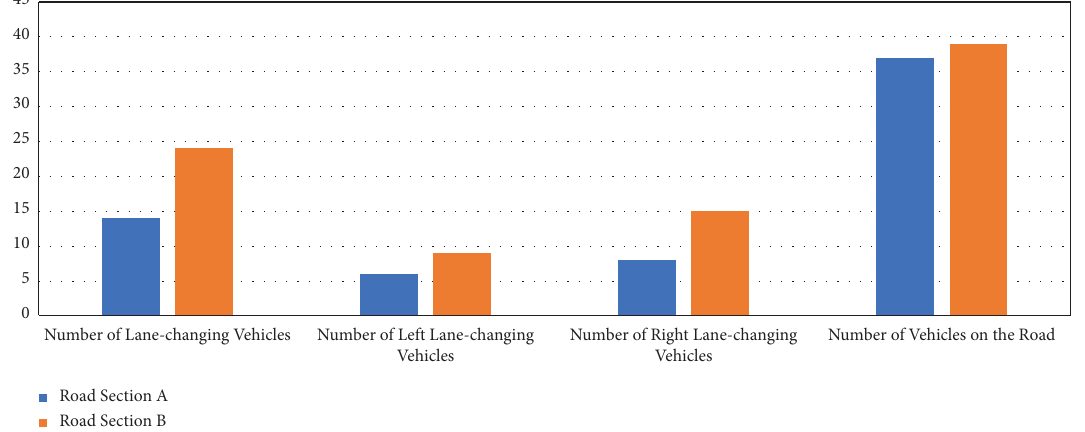
Figure 11: Statistical results of lane-changing